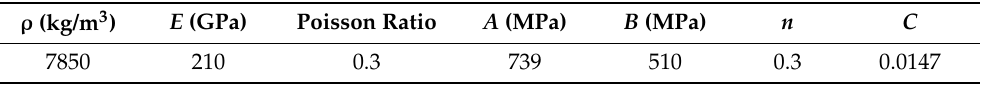
Table 1. Parameters of the E690 high-strength steel Johnson-Cook (J-C) model. ρ (kg/m 3 )